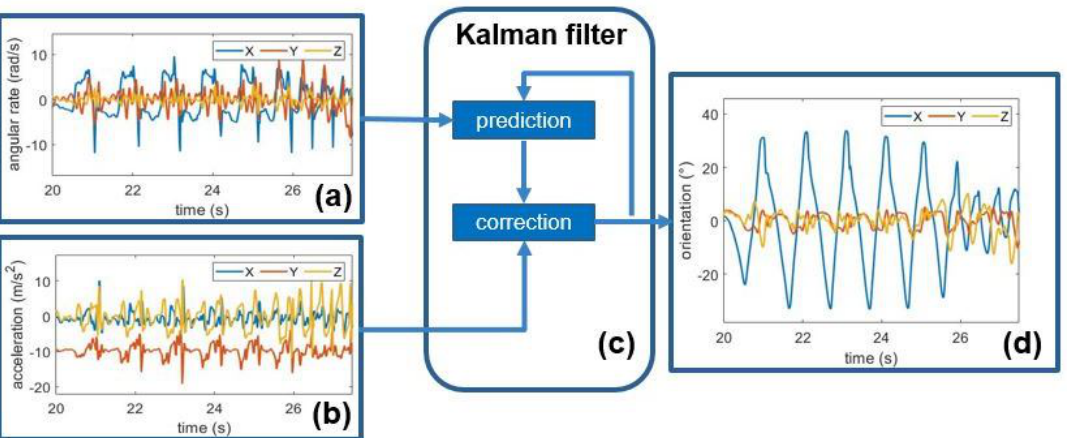
Figure 2. Schematic of the Kalman filter, together with input and output. Raw gyroscope ( a ) and accelerometer ( b ) readings are input to the Kalman filter ( c ) to provide an estimate of orientation ( d